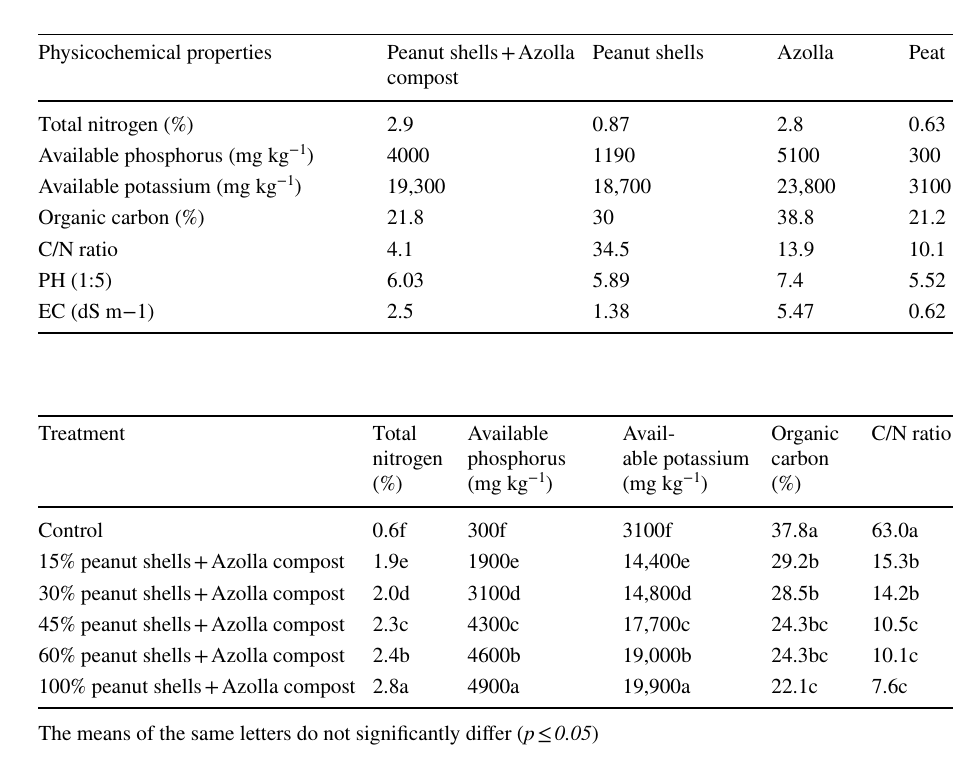
The means of the same letters do not significantly differ ( p ≤